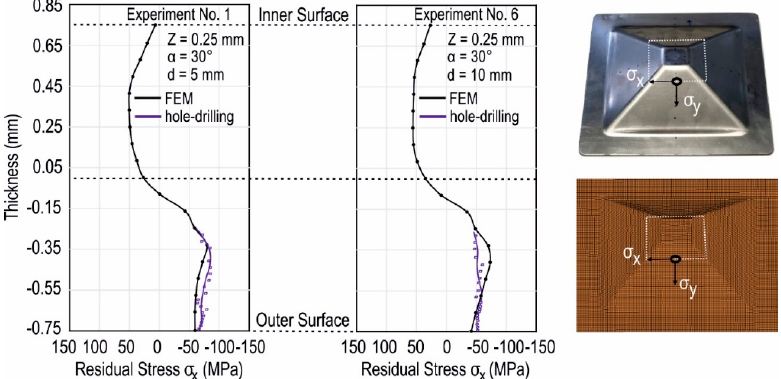
Figure 8. Comparison of the residual stresses along the tool motion direction, i.e., σ x at selected location for Experiments 1 and